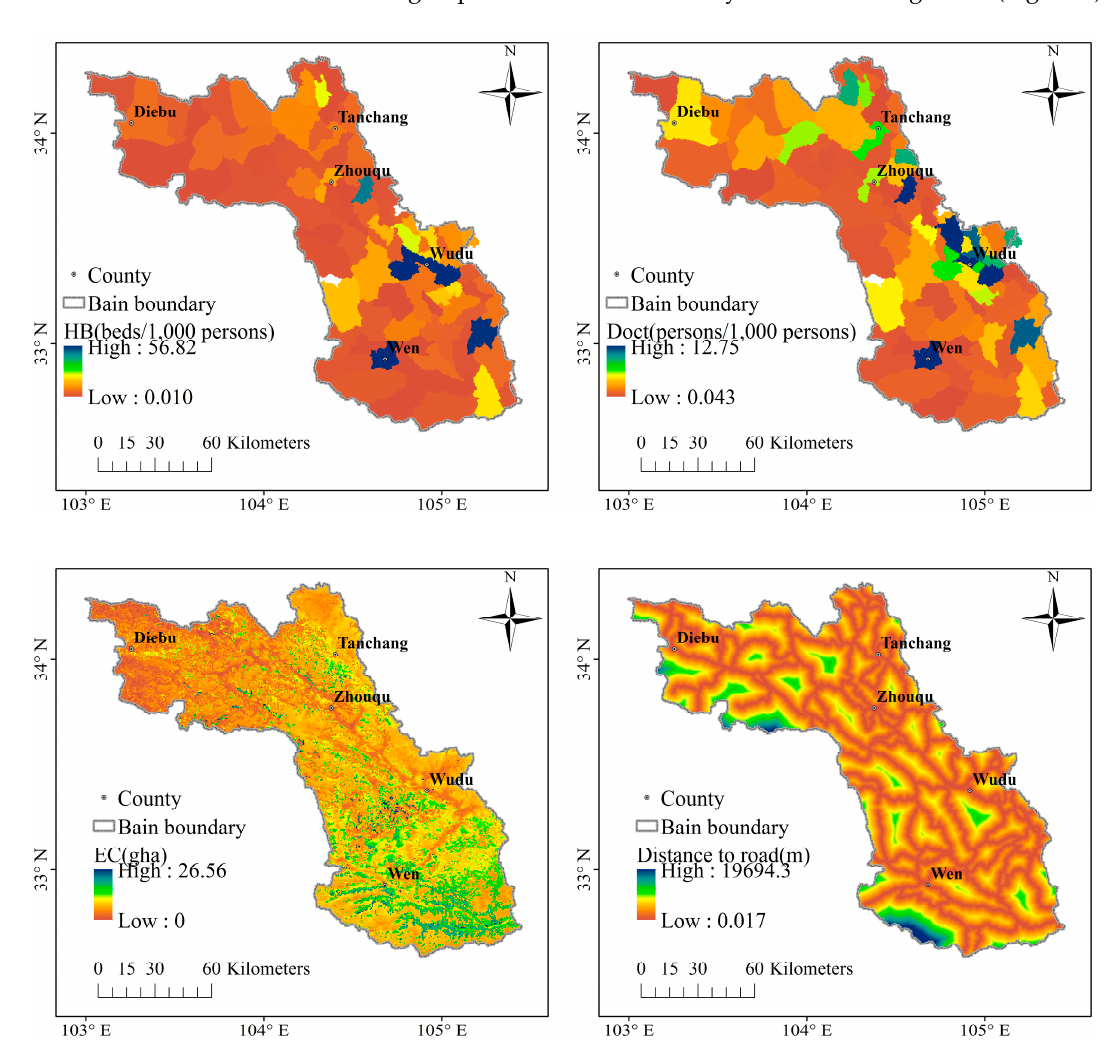
Figure 8. Spatial distribution of factors characterising coping capacity.